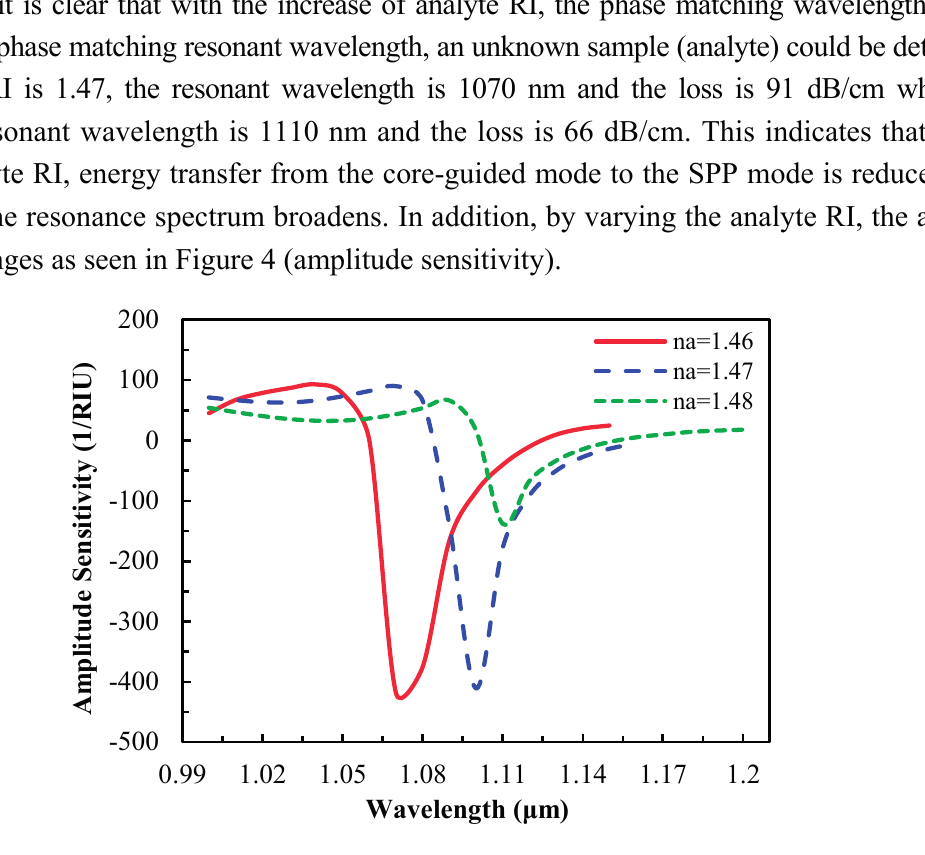
Figure 4. Amplitude sensitivity as a function of wavelength with the variation of analyte